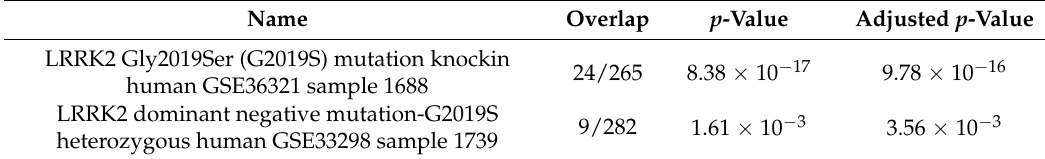
Table 7. Top ranked two LRRK2 KO/KI experiments in “Single Gene Perturbations from GEO down”.